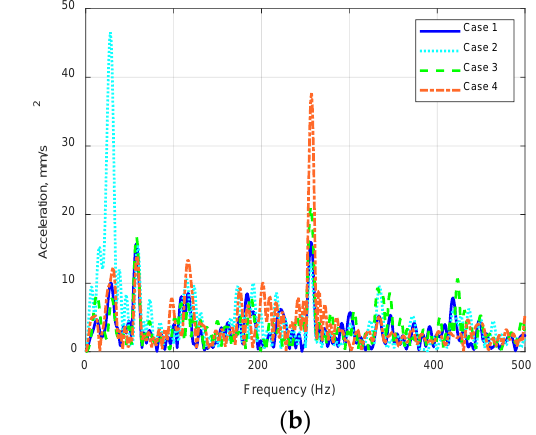
Figure 13. ( a ) CVib of Case 1 to Case 4. ( b ) FFT result.